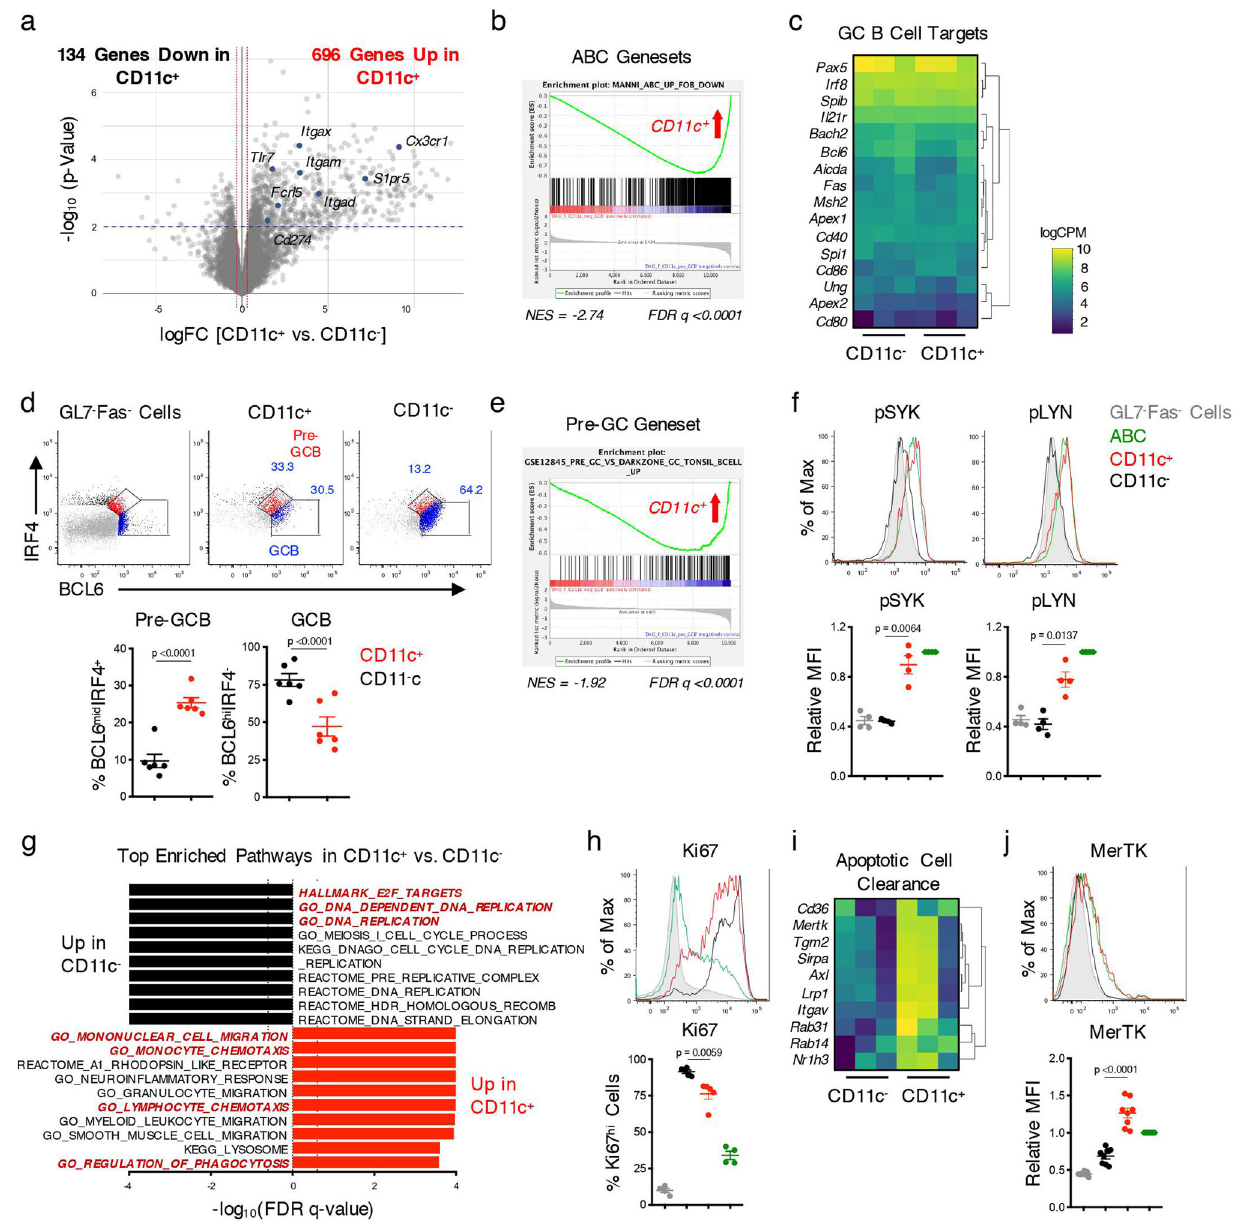
Fig. 5 CD11c + GC B cells exhibit a pre-GC B cell phenotype. RNA-seq was performed on sorted CD11c + and CD11c − GL7 + CD38 lo B cells (gated on B220 + splenocytes) from aged (24 + wk) female DKO (F) mice. a Volcano plot showing genes differentially expressed ( p <0.01 after Benhamini – Hochberg false discovery rate (FDR) was used to correct for multiple comparisons) between CD11c + B220 + GL7 + CD38 lo (CD11c + ) and CD11c − B220 + GL7 + CD38 lo (CD11c − ) cells. b Plot showing the enrichment of the ABC geneset from DKO mice in CD11c + B220 + GL7 + CD38 lo cells. c Heatmap showing the expression of GC B cell target genes in CD11c + and CD11c − B220 + GL7 + CD38 lo cells. d Representative plots and quanti fi cations of pre-GC B cells (BCL6 mid IRF4 + ) and GC B cells (BCL6 hi IRF4 − ) among CD11c + CD19 + GL7 + Fas + (CD11c + ; red) and CD11c − CD19 + GL7 + Fas + (CD11c − ; black) cells from aged (24 + wk) DKO(F) mice. Data show mean±SEM; n = 6 from 2 independent experiments; p -value by paired two-tailed t -tests. e Plot showing the enrichment of a pre-GC geneset (GSE12845) in CD11c + B220 + GL7 + CD38 lo cells. f Representative histograms and quanti fi cations of the phosphorylation of SYK(Y352) and LYN(Y416) in CD11c + CD19 + GL7 + Fas + cells (CD11c + ; red), CD11c − CD19 + GL7 + Fas + (CD11c − ; black) cells from aged (24 + wk) DKO(F) mice. CD19 + CD11c + CD11b + (ABCs; green) CD19 + GL7 − Fas − cells (gray) are shown as control. Data show mean±SEM; n = 4 from 3 independent experiments; p -value by paired two- tailed t -test. g Plot showing the top pathways upregulated in CD11c − GL7 + CD38 lo cells (black) and CD11c + GL7 + CD38 lo cells (red) by GSEA. Dotted line indicates signi fi cance threshold at FDR q <0.25. h Representative histogram and quanti fi cation of Ki67 expression in the indicated populations from DKO(F) mice. Data show mean±SEM; n = 5 from 3 independent experiments; p -value by paired two-tailed t -tests. i Heatmap showing the expression of genes related to apoptotic cell clearance in CD11c + and CD11c − GL7 + CD38 lo cells from DKO ( F) mice. j Representative histogram and quanti fi cation of MerTK expression on the indicated populations from aged (24 + wk) DKO(F) mice. Data show mean±SEM; n = 8 from 4 independent experiments; p -value by paired two-tailed t